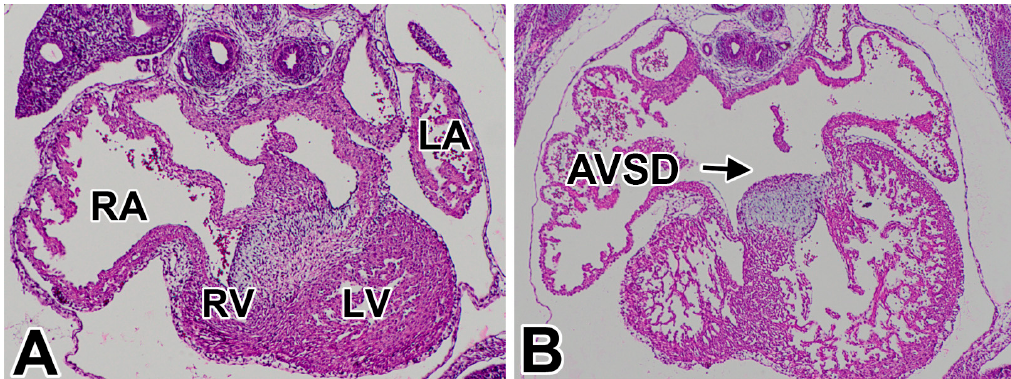
Figure 5. Atrioventricular septal defect in Mef2C-AHF-Cre;Alk3 fl/fl mouse at ED13.5 Histological analysis of control (A) and SHF-specific Alk3 knockout (B) mouse embryos at ED13.5 shows that while the atrioventricular valvuloseptal complex is complete in the control specimen (A) the deletion of Alk3 from the SHF has resulted in an incomplete AVSD in the SHF-specific Alk3 knockout embryo (B). AVSD = atrioventricular septal defect, LA = left atrium, LV = left ventricle, RA = right atrium, RV = right ventricle.